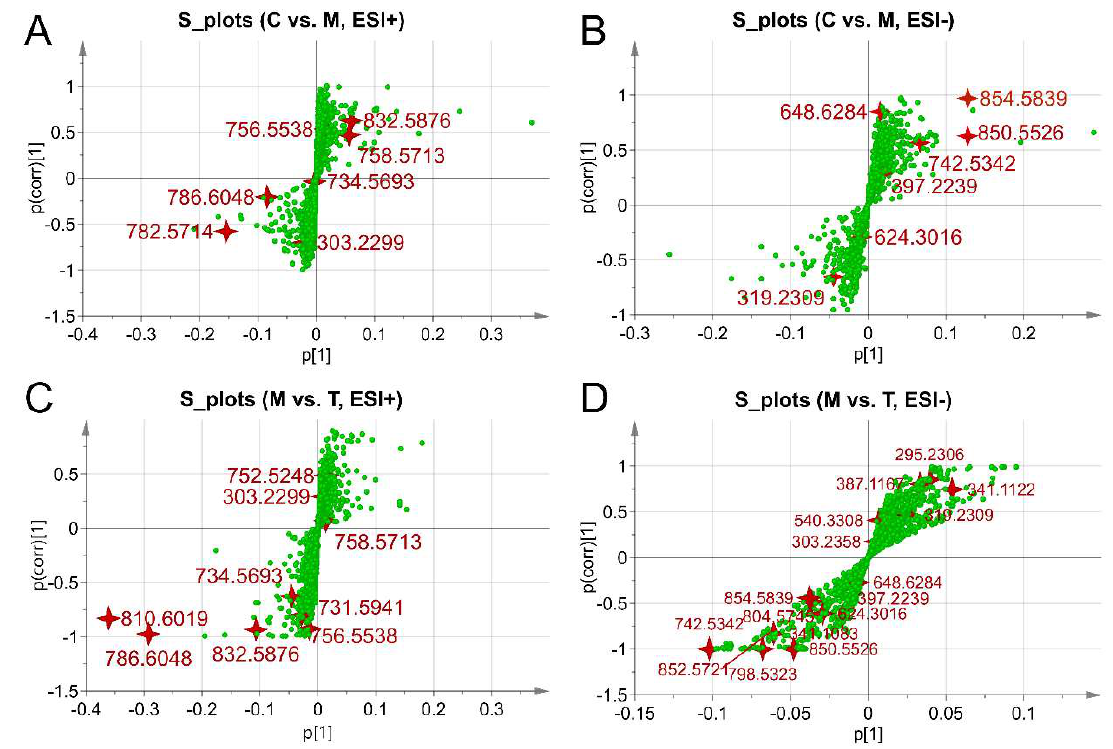
Figure 10. S-plots of all differentiated metabolites based on the OPLS-DA models. C vs. M in ESI+ ( A ) and in ESI − ( B ); M vs. T in ESI+ ( C ) and in ESI − ( D ). All of the significantly changed metabolites identified were marked as red four-polar stars. Other components were green points. The p [1]-axis describes the magnitude of each variable in X. The p (corr) [1]-axis represents the reliability of each variable in X. Control was abbreviated as C, Model as M, Treatment with drugs as T.